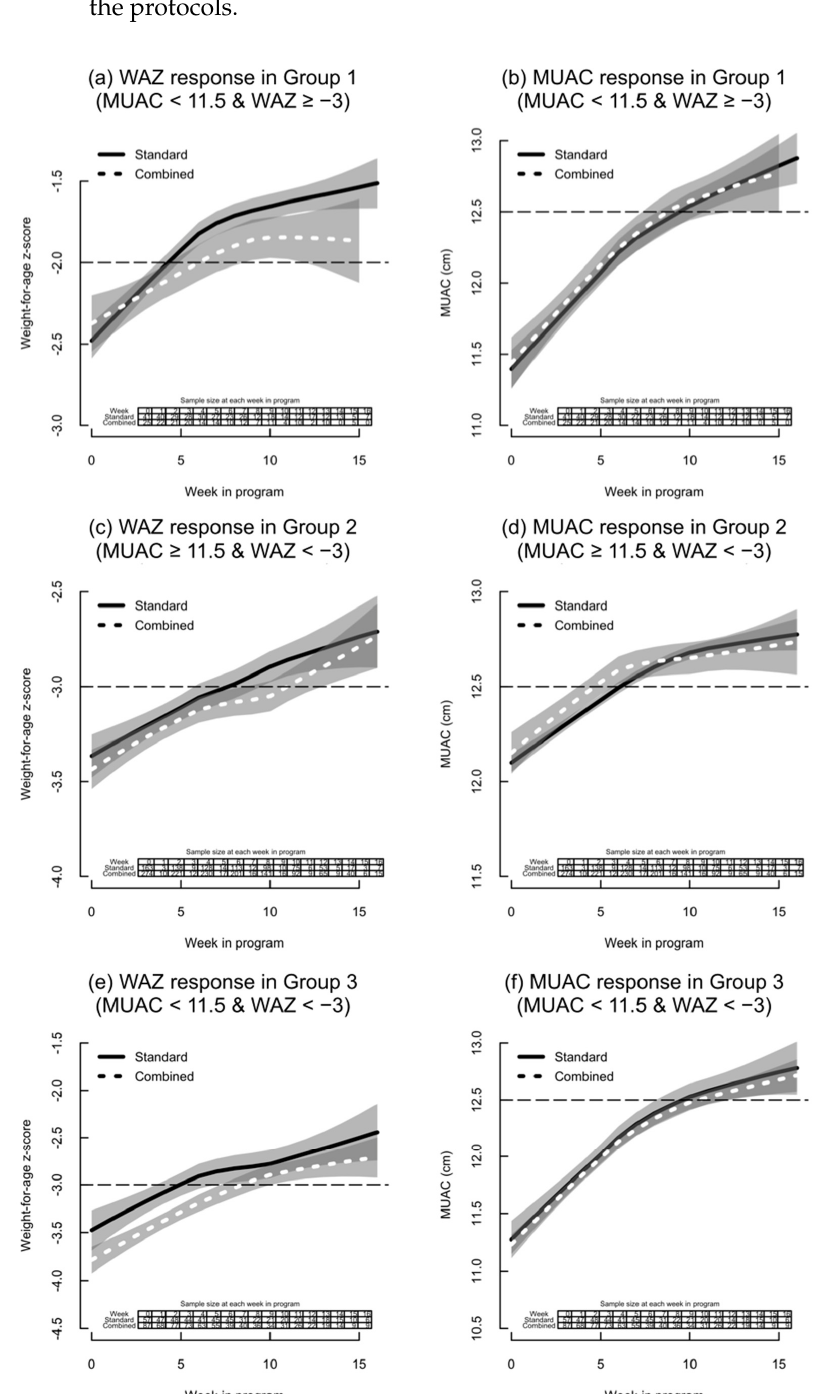
Figure 2. Panel of WAZ and MUAC response among recovered children by admission group. MUAC, mid-upper arm circumference; WAZ, weight-for-age z-score. ( a ) WAZ plotted against week in program for Group 1; ( b ) MUAC plotted against week in program for Group 1; ( c ) WAZ plotted against week in program for Group 2; ( d ) MUAC plotted against week in program for Group 2; ( e ) WAZ plotted against week in program for Group 3; ( f ) MUAC plotted against week in program for Group 3. The shaded areas represent a 95% confidence band around each curve (i.e., the area between the upper and lower 95% confidence limits is shaded). Overlaps between confidence intervals are more darkly